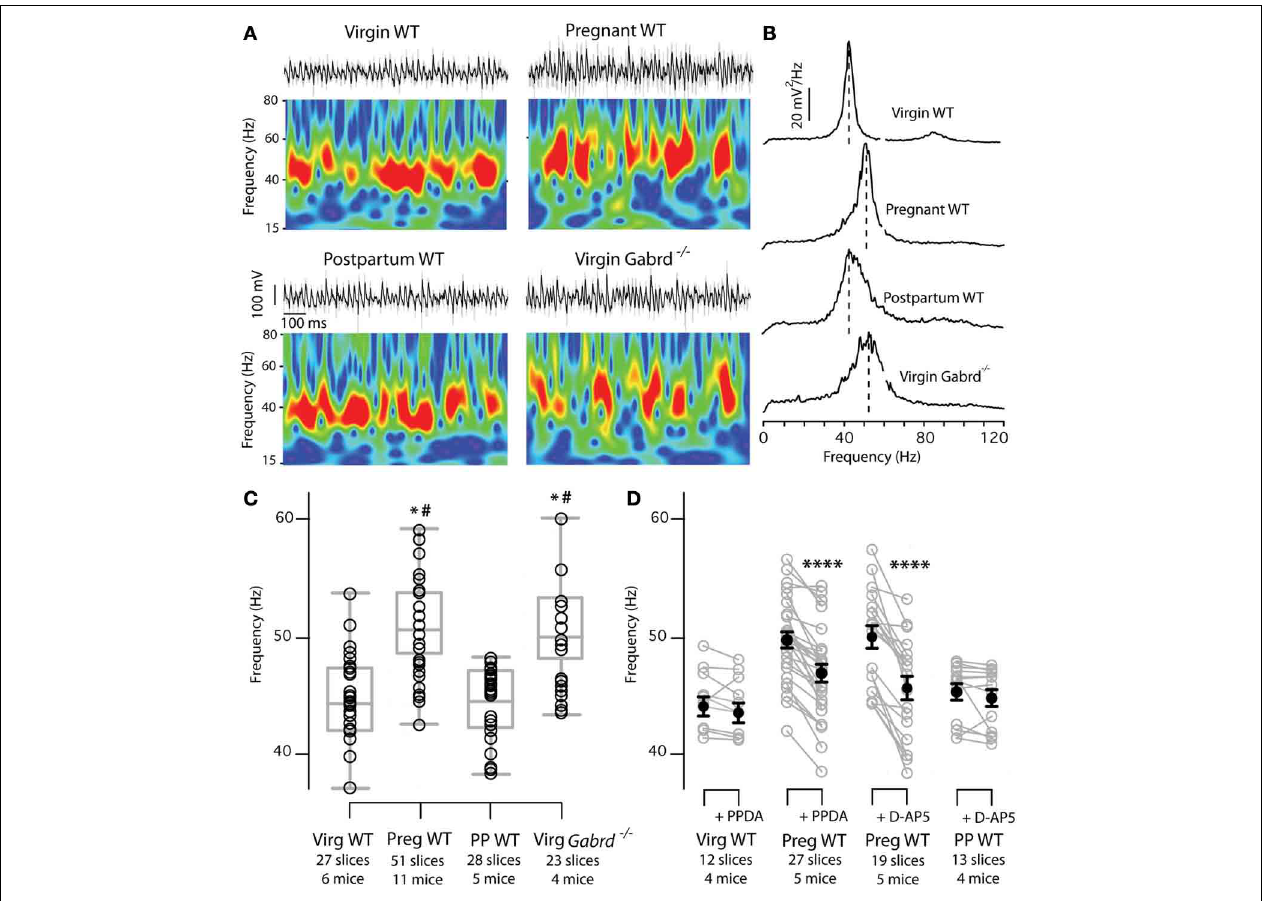
FIGURE 6 | γ Oscillations frequency is increased in the CA3 of pregnant animals in the absence of physiological ALLO levels. Increased CA3 γ oscillations frequency in slices of WT pregnant mice is sustained by NMDA-Rs activation on interneurons. (A) Kainate induced γ oscillations (50nM) recorded extracellularly in CA3 stratum pyramidale at different gestational states show higher frequency in slices of WT pregnant and Gabrd − / − virgin mice compared to slices from WT virgin and postpartum mice. Upper traces: representative 1s epochs of LFPs band-pass filtered between 15 and 120Hz (black) and raw traces (gray). Morlet wavelet transforms of the corresponding traces show γ oscillatory behavior. Warmer colors represent higher power, and the same scale has been used for all four wavelets. (B) Plots of power spectral density calculated over 180s periods of the same recordings as in (A) . Note increased γ frequency in slices from pregnant and Gabrd − / − mice. No differences are found in power at peak frequency or total power (30–120Hz) (C) , Box plots showing peak frequencies for the four experimental groups. Each dot symbolizes the peak frequency of one slice calculated as the frequency with the highest power in